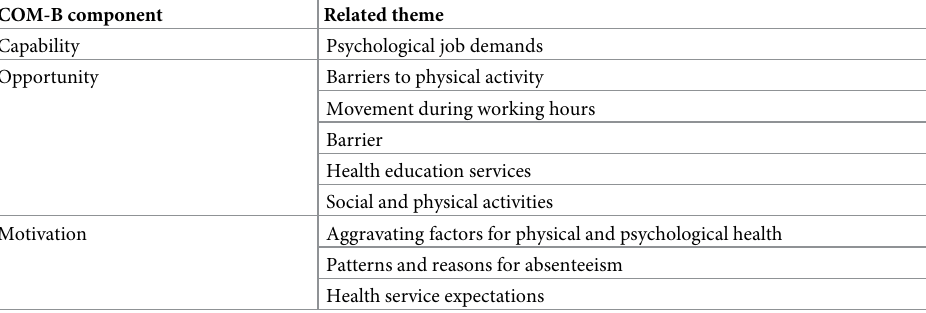
Table 5. Mapping of the COM-B model to the themes